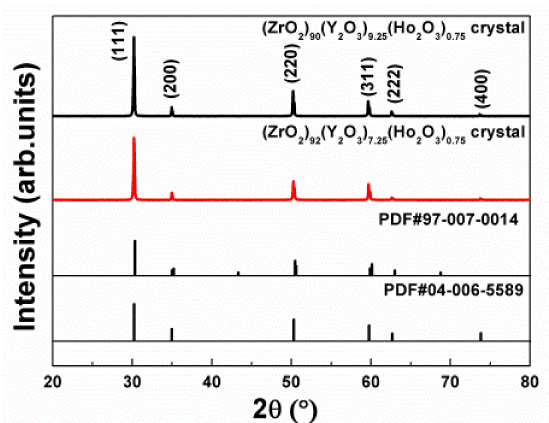
Figure 3. XRD patterns of (ZrO 2 ) 92 (Y 2 O 3 ) 7.25 (Ho 2 O 3 ) 0.75 and (ZrO 2 ) 90 (Y 2 O 3 ) 9.25 (Ho 2 O 3 ) 0.75 powders ground from the